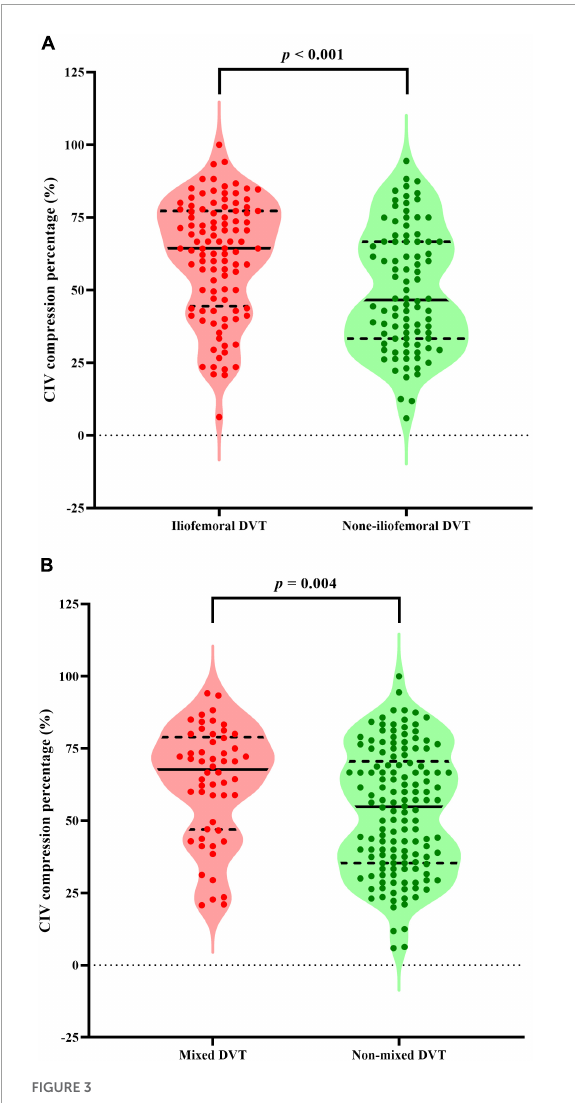
FIGURE3 Violin plots presenting all points and the median value (solid lines) with interquartile range (dashed lines) of CIV compression percentage for patients with iliofemoral DVT (A) or mixed DVT (B) . Mann–Whitney U tests show that patients with iliofemoral DVT or mixed DVT had significantly greater median compression percentage than those without iliofemoral DVT or mixed DVT, respectively ( p < 0.001 and p = 0.004, respectively). CIV, common iliac vein; DVT, deep vein